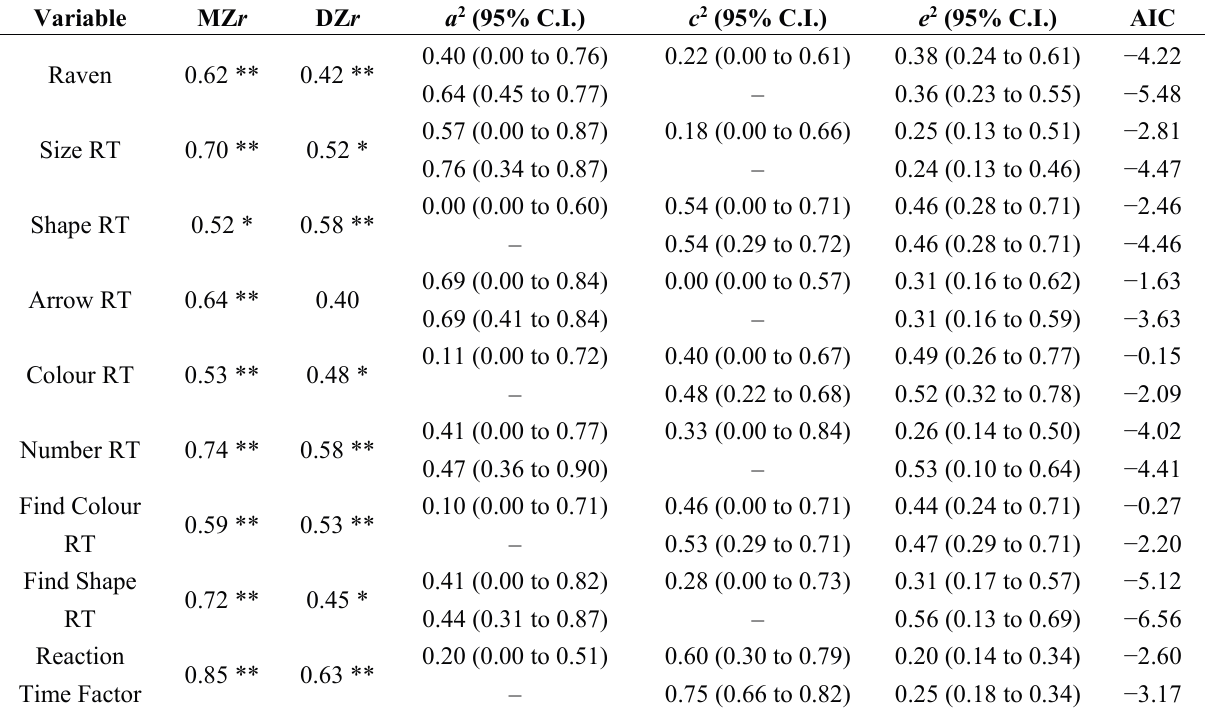
Table 1. MZ and DZ correlations and results of univariate genetic